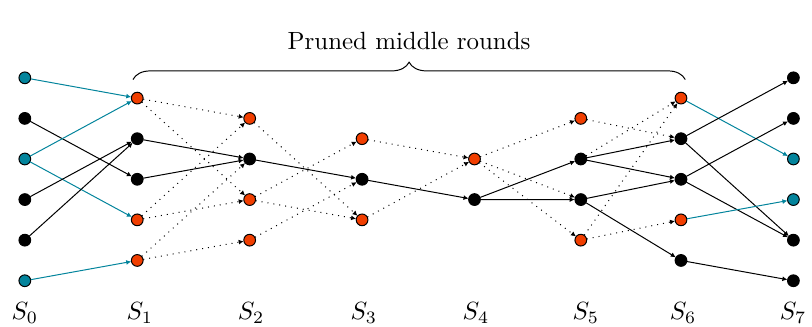
Figure 4: An illustration of vertex anchoring. The black and red graph represents trails built from the set of single round approximations A . The red subgraph would be removed if the red/black graph was pruned. The blue anchor vertices are added to prevent the red subgraph from being removed, increasing the number of trails